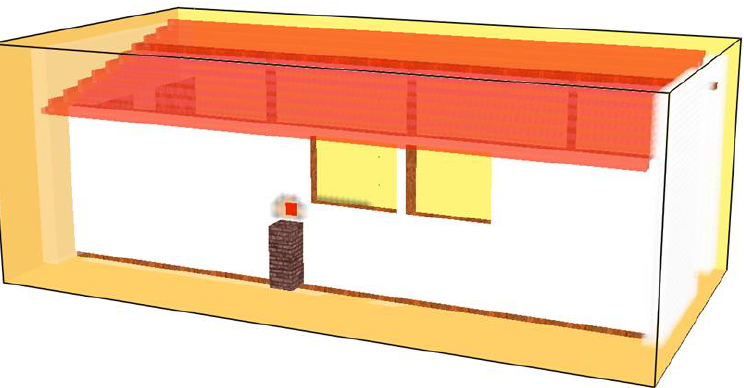
Figure 13. Ignition of the eastern wall cladding with extruded polystyrene due to the incandescent flour particles emitted through the flexible aluminum tube without self-support or extension of the brick chimney.